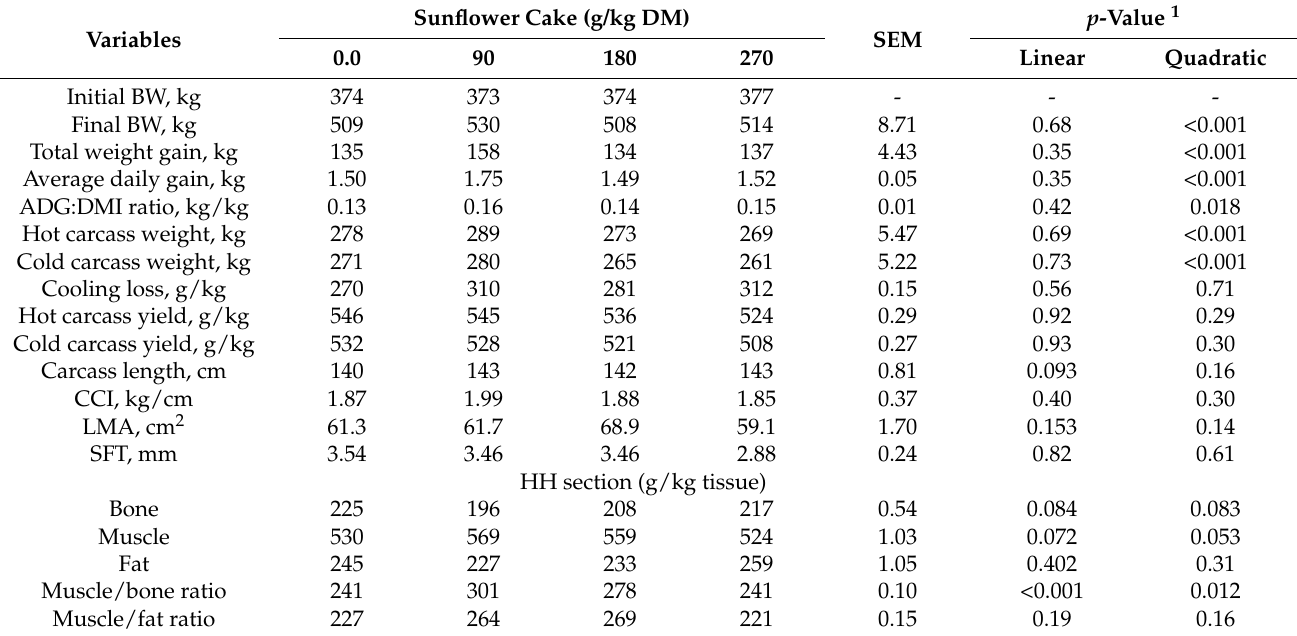
Table 5. Performance and carcass traits of young bulls fed sunflower